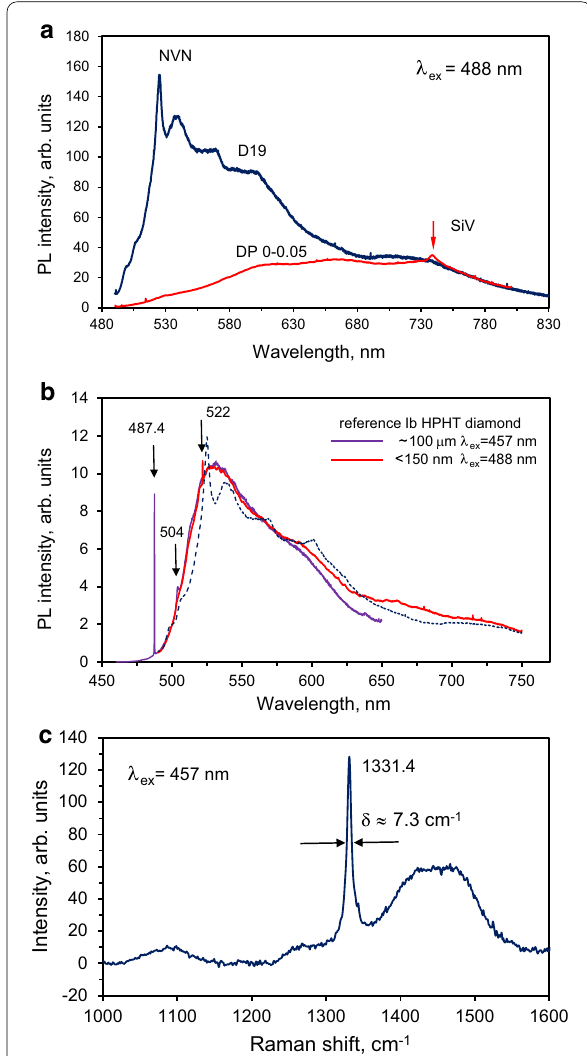
Fig. 9 PL spectrum of submicron powder D19 sample at T 293 K = (blue line) compared with that of its DP 0–0.05 polycrystalline precursor (red line) under the same conditions with laser excitation at λ 488 nm ( a ), emission spectra, under 457 nm and 488 nm = excitation, of two reference synthetic HPHT samples (size ~ 100 μm and < 150 nm) containing NVN centres ( b ) and the Raman spectrum of D19 sample recorded using the 457 nm excitation laser radiation ( c ). Arrows in ( b ): lines at 487.4 nm and 522 nm are single-phonon diamond Raman lines at 457 nm and 488 nm excitation, respectively, and the line at 504 nm is the ZPL of the NVN centres. In (b): dashed line—PL spectrum of D19 at λ 488 nm excitation (for comparison). = In ( c ): the diamond Raman line is centred at 1331.4 cm − 1 . δ 7.3 cm − 1 is a FWHM of diamond Raman line having the Lorentzian =